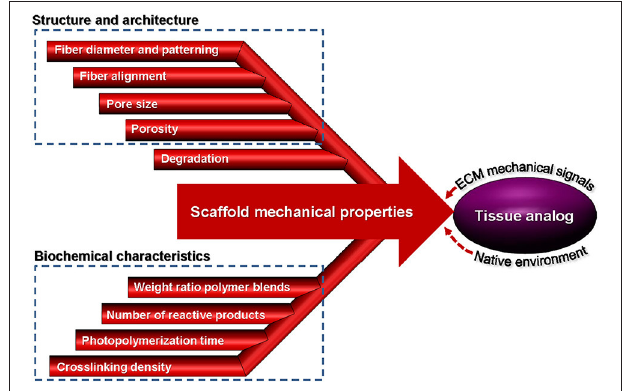
FIGURE 5 | Parameters affecting the mechanical properties of scaffolds from fabrication to implantation used to create a tissue analog.